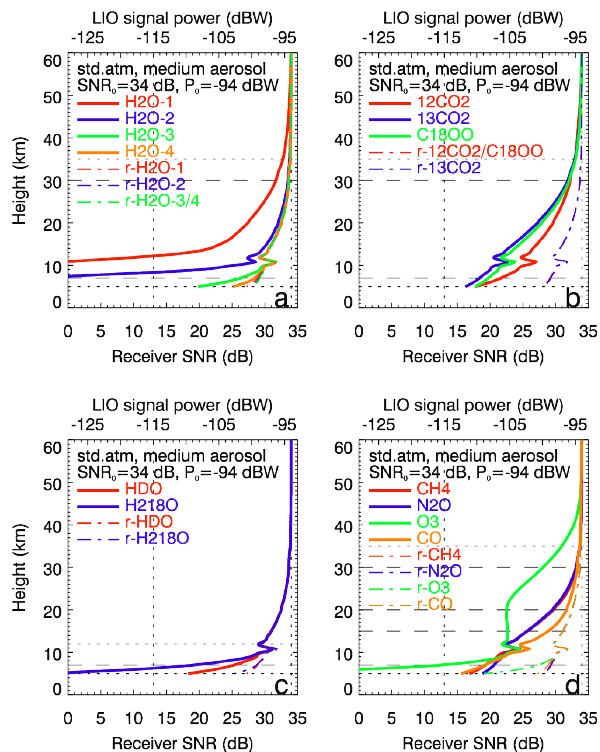
Fig. 10. Received signal power (upper axes) and receiver SNR (lower axes) for the channels listed in Table 1 on the basis of adopting a top-of-atmosphere power of − 94 dBW and a corresponding SNR of 34 dB , both being baseline values of the ACCURATE mission design. The results are shown for the FASCODE STD atmosphere and medium aerosol load. The layout of the panels is the same as in Fig. 4.